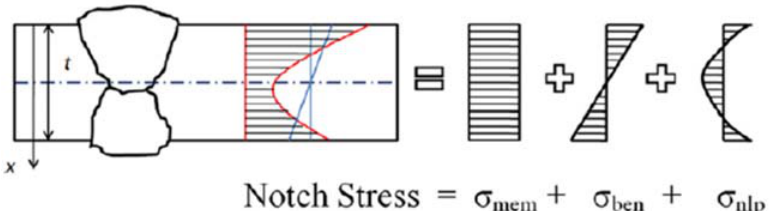
Figure 5: Stress distribution through the thickness of the weld plate and its components